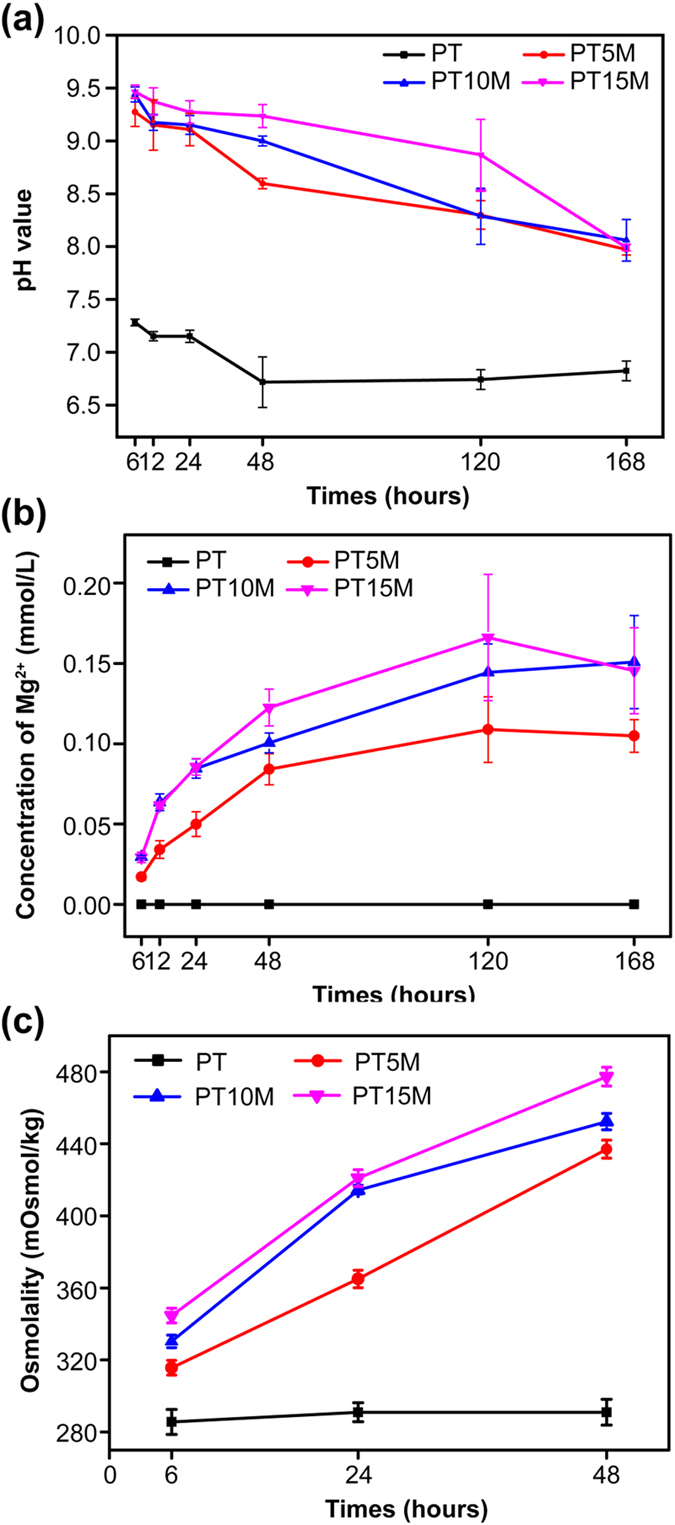
Degradation features of the PLGA/TCP/Mg scaffolds:(a) Changes in pH of the degradation medium; (b) Changes in ionic concentration of Mg2+; (c) Changes in osmolality.